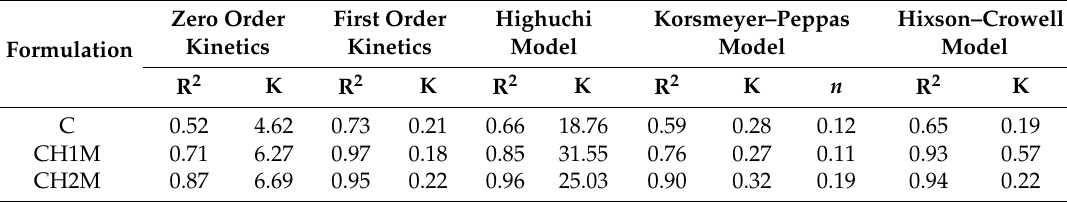
Table 3. Models of MF release from non cross-linked microparticles formulations C and cross-linked microparticles formulations CH1M, CH2M.